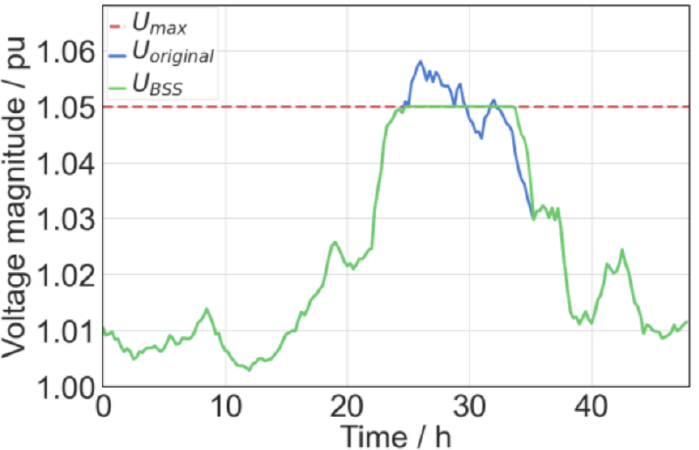
Figure 16. Voltage magnitude on node 5, initially (blue trace) and after application of BSS (green trace).